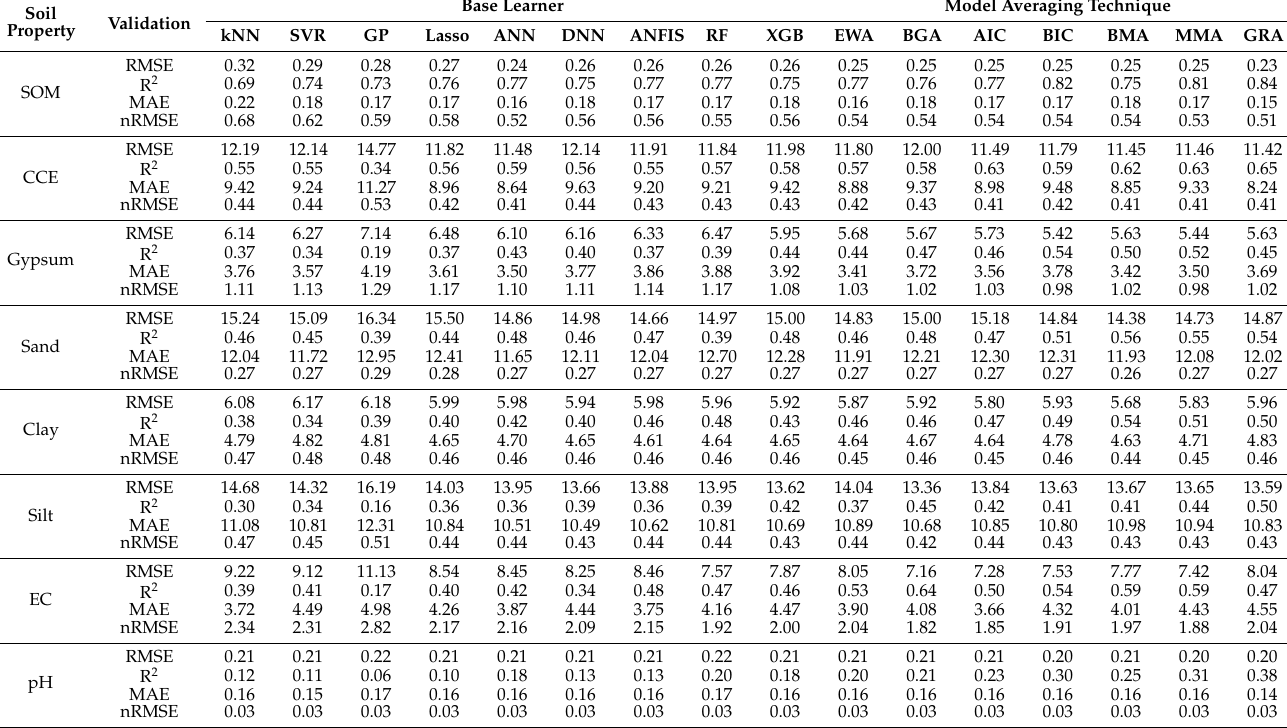
Table 3. Summary of accuracy metrics for base learners and model averaging